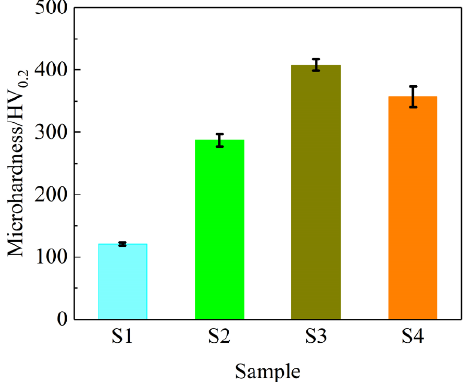
Figure 7. Microhardness of all samples.